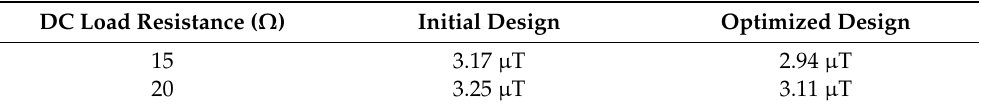
Table 6. LMF strength measured in the maximum-misalignment case.